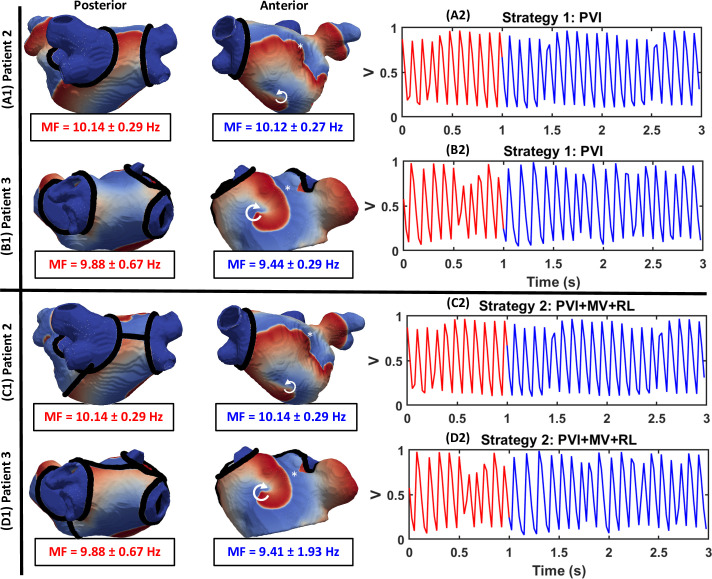
CA with the clinical used ablation Strategies 1 and 2 failed to terminate AF in the majority of cases.Left: Voltage maps showing the behaviour of RDs after: (A1-B1) Strategy 2 and (C1-D1) Strategy 2 in Patient 2 and 3, respectively. Right: Transmembrane voltage at the point indicated by * in the respective LA models, plotted before (red) and after (blue) CA. Both strategies failed to terminate RDs in all cases and MF remained unaffected. Here and in the next figure, the white arrow indicates the directions of RD movement.